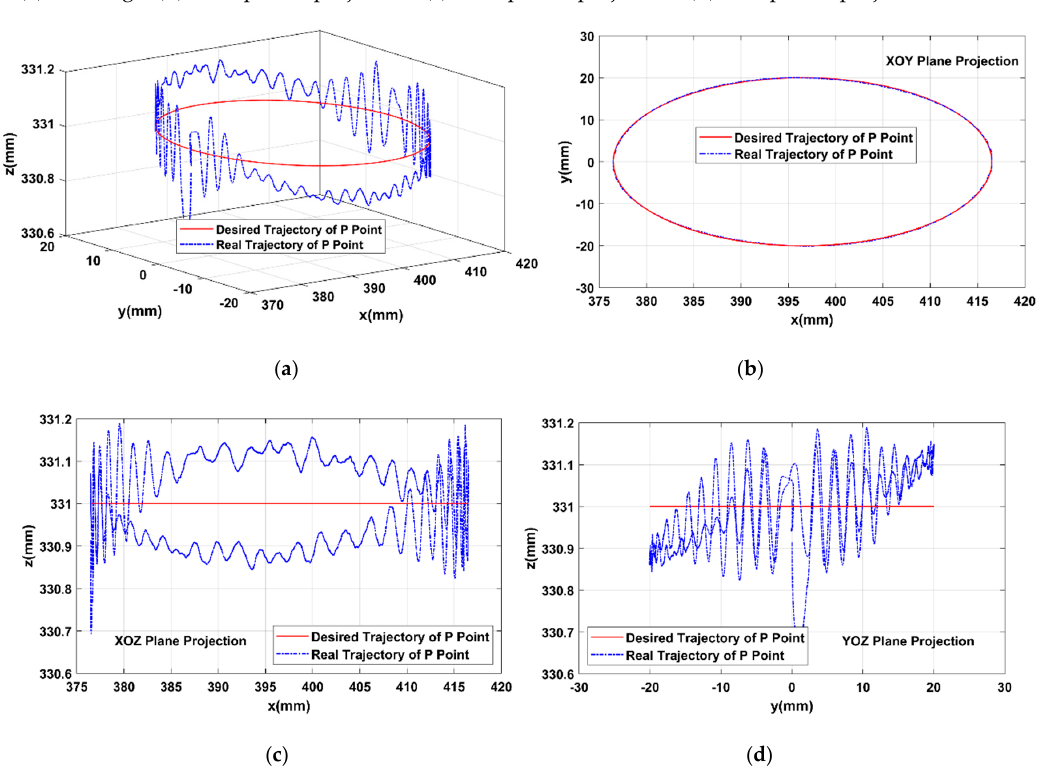
Figure 10. Robot end-point Cartesian follow-up trajectory using ADRC controller (w = 2 rad/s). ( a ) 3D image; ( b ) XOY planar projection; ( c ) XOZ planar projection; ( d )YOZ planar projection.